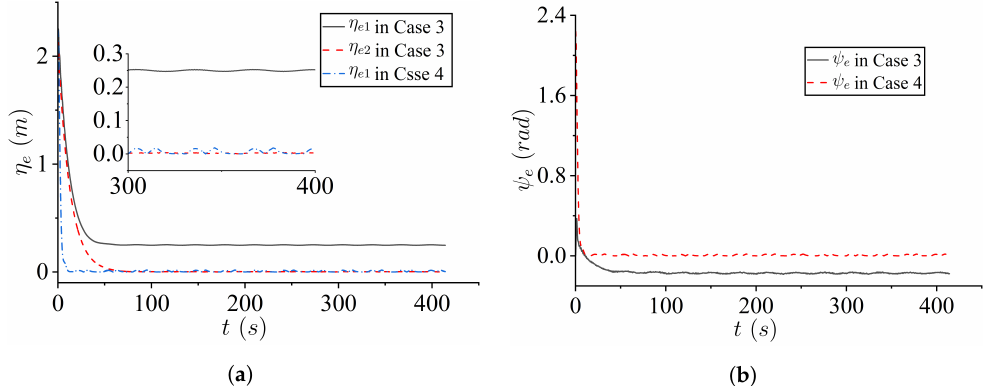
Figure 8. The tracking errors in Case 3 and Case 4: ( a ) position error, ( b ) heading angle error.